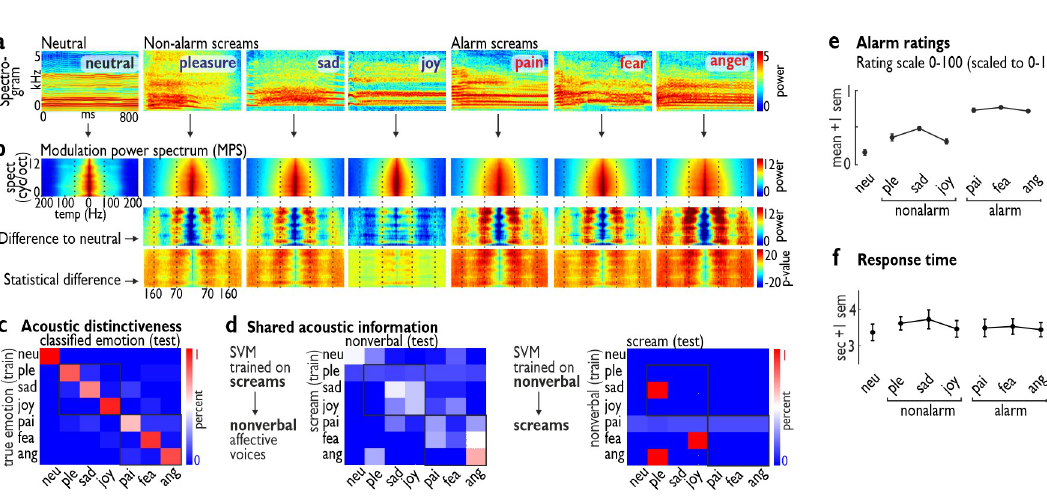
Fig 1. Acoustic description and alarm ratings of 6 distinctive types of screams. (a) Spectrograms of example stimuli for each scream type, including a neutral scream of an intense vocalization of the vowel /a/. (b) Average modulation power spectrum (MPS) for each scream type (upper row) as the numeric (middle row) and statistical difference (lower row; n = 60 per scream type; n = 420 screams in total) of each scream type from neutral screams. (c) Using a support vector machine (SVM) on the acoustic features of each scream allowed us to separate each scream type from other screams with high accuracy (e.g., low level of off-diagonal misclassifications). (d) To test whether screams share acoustic information with common nonverbal affect bursts, we trained the SVM either on the screams (left) or on the nonverbal affect bursts (right) and tested the classifier on the other type of affective vocalizations; in both cases, the SVM classifier failed to show superior performance (e.g., high level of off-diagonal misclassifications). (e) Alarm level ratings ( n = 23) confirmed the differential level of alarm of screams that seem to be of a low alarming nature (non- alarm screams: pleasure, sadness, joy) and a high alarming nature (alarm screams: pain, fear, anger). (f) Response times for the alarm ratings as performed in a non-speeded task by moving a slider on a visual analog scale to the appropriate alarm level for each scream. Numerical data underlying the plots (c–f) can be found in S1 Data. ang, anger; fea, fear; neu, neutral; pai, pain; ple, pleasure; sad, sadness; sem, standard error of the mean; test, testing data; train, training